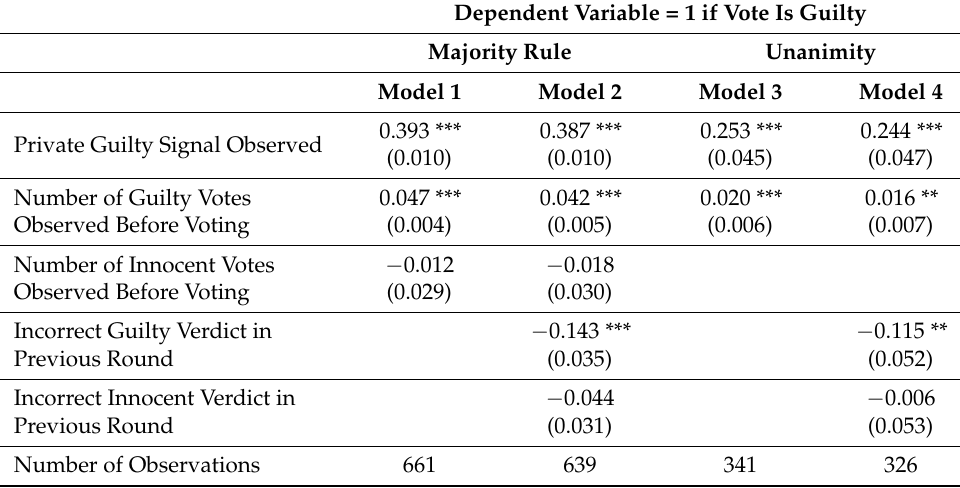
Table 5. Marginal effects from probit models of the decision to vote